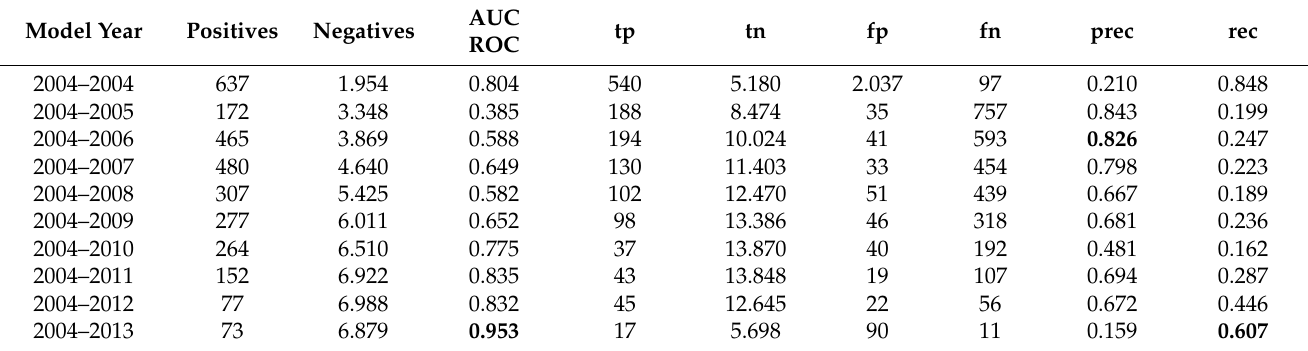
Table 3. Number of positives, negatives, area under the receiver operating characteristic curve (AUC- ROC), predicted true-positives (tp) and true-negatives (tn), false-positives (fp), and false-negatives (fn). Precision or positive predictive value (prec) and recall or sensitivity (rec) for each model year (by row, indexed by the column year) related to their corresponding test sets. Bold face is used to highlight the best performance column wise.